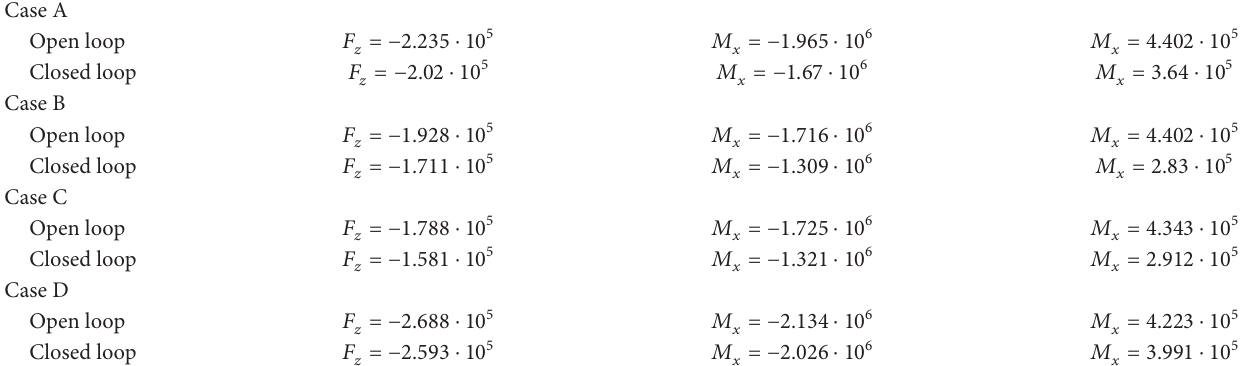
Table 4: Open and closed loop responses for the cases of Table